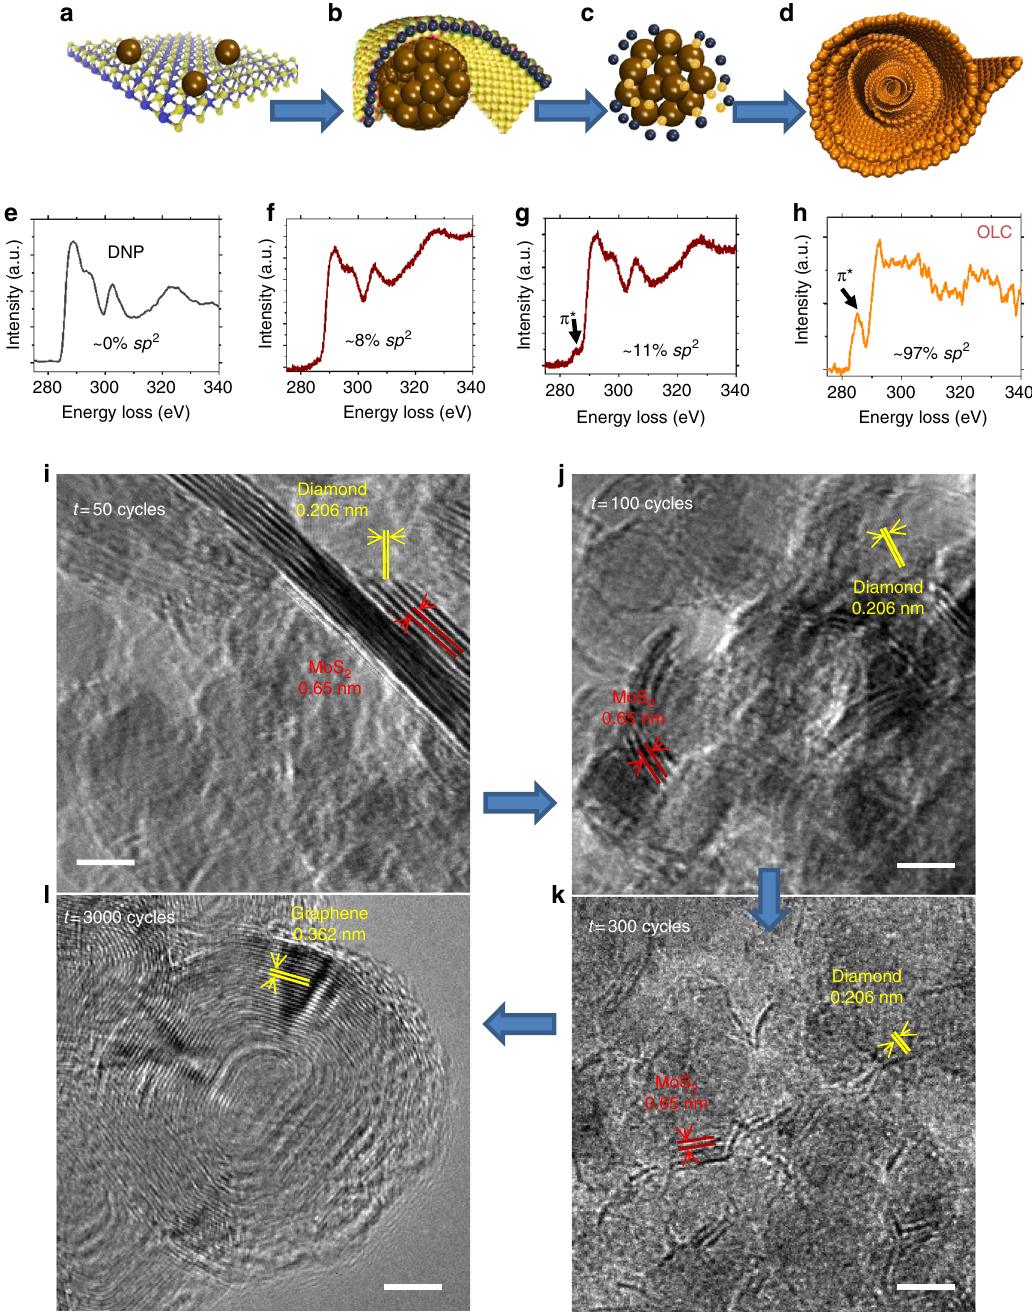
Fig. 2 Schematics of the mechanism of the onion-like carbon formation during sliding. Schematics depicting the mechanism of OLC formation: a dispersion of MoS 2 and nanodiamonds on the surface, b wrapping of MoS 2 sheets around nanodiamonds, c partial disintegration of MoS 2 and amorphization of nanodiamond, and d formation of OLCs. Electron energy loss spectra highlighting the calculated fraction of sp 2 -bonded carbon and tracking full transformation from e nanodiamonds into partially graphitized f , g structures and into h OLC structures. i – l TEM images of the wear debris taken at regular intervals after interrupting the tribotest and corresponding to four stages ( a – d ) of transformation. Image i indicates good dispersion of MoS 2 sheets along with nanodiamonds; j initial breaking of MoS 2 layers and wrapping around nanodiamonds; k further wrapping of them around the nanoparticles and reduction in the size of nanodiamonds due to the tribochemical reaction leading to amorphization and precipitation of amorphous carbon; and l complete transformation into OLCs in the wear track with no indication of MoS 2 layers inside the wear track. The presence of the initial mixture of diamond and MoS 2 and the OLC structures is indicated by interlayer spacing in the diamond lattice, as well as between MoS 2 and graphitic layers. The scale bars are 5